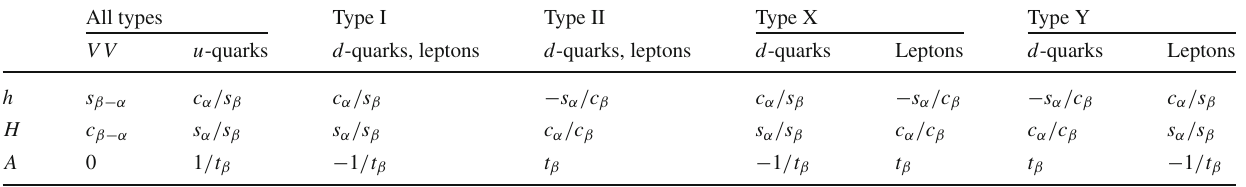
Table 2 Tree-level vector boson couplings, C V , and fermionic couplings, C F , normalised to the SM-Higgs couplings for the h , H , A fields in the four 2HDM types;